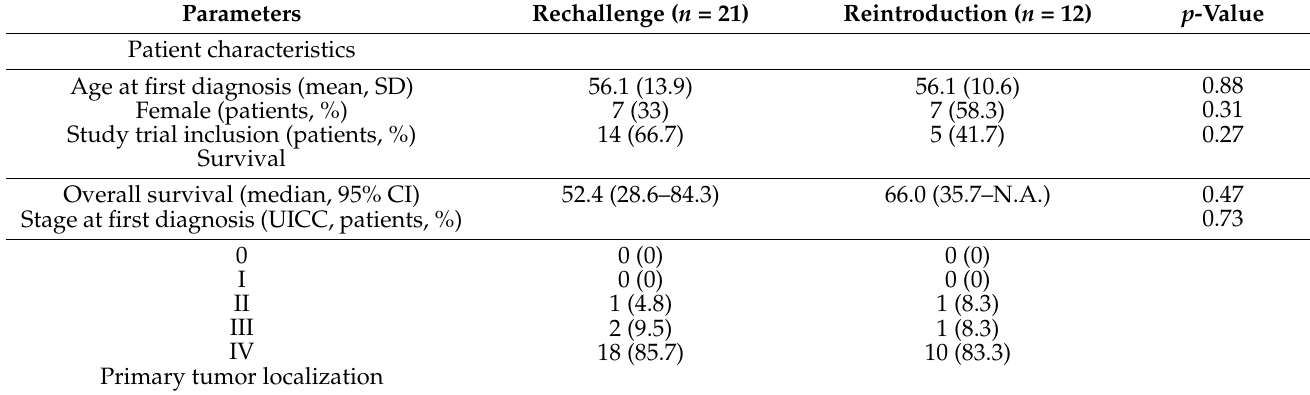
Table 3. Characteristics of patients with anti-EGFR rechallenge and anti-EGFR reintroduction.